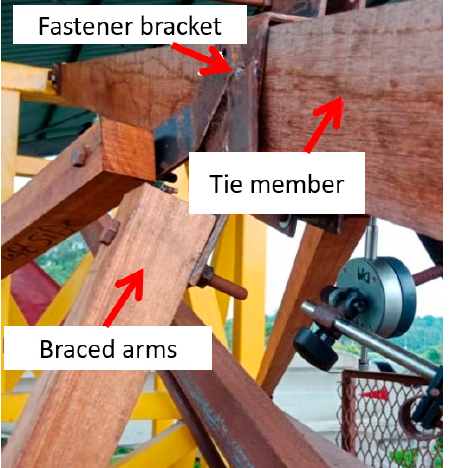
Figure 5. Mild steel fastener bracket joins the braced arms with tie members.